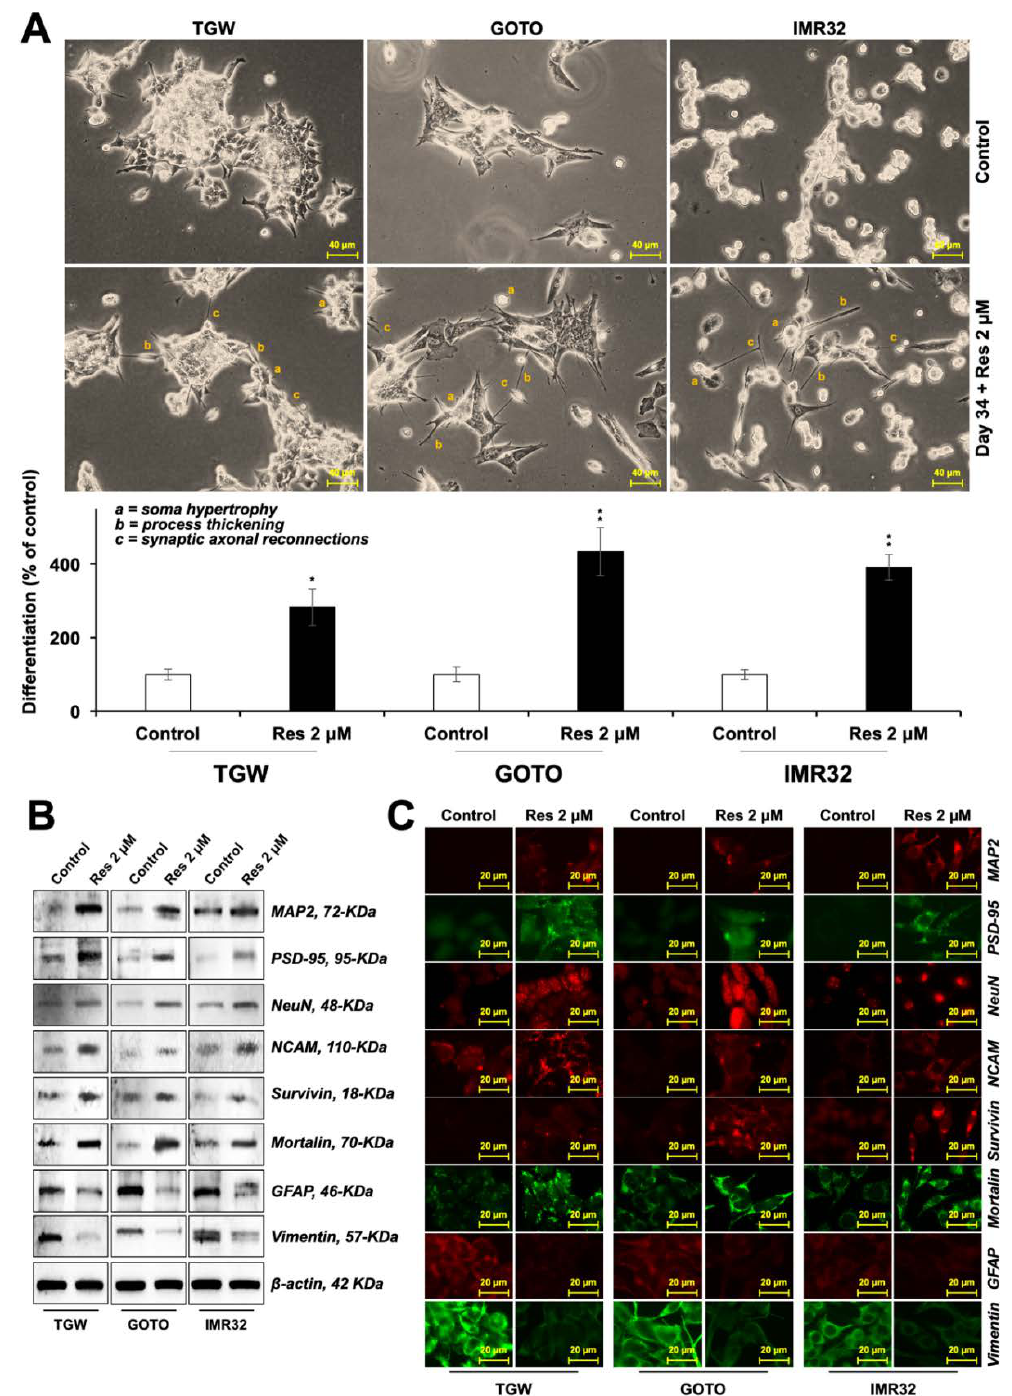
Figure 7. Resveratrol caused differentiation in human neuroblastoma cells. ( A ). Images summarizing cell morphology in the control and resveratrol (res)-treated cells for 34 days. The number of cells showing differentiated morphology out of 100 cells from three random fields were plotted on a histogram, where control was taken as 100%. Western blotting ( B ) and immunostaining ( C ) results showing induction of neuronal-type differentiation in resveratrol-treated human neuroblastoma cells along with the suppression of glial-related proteins.